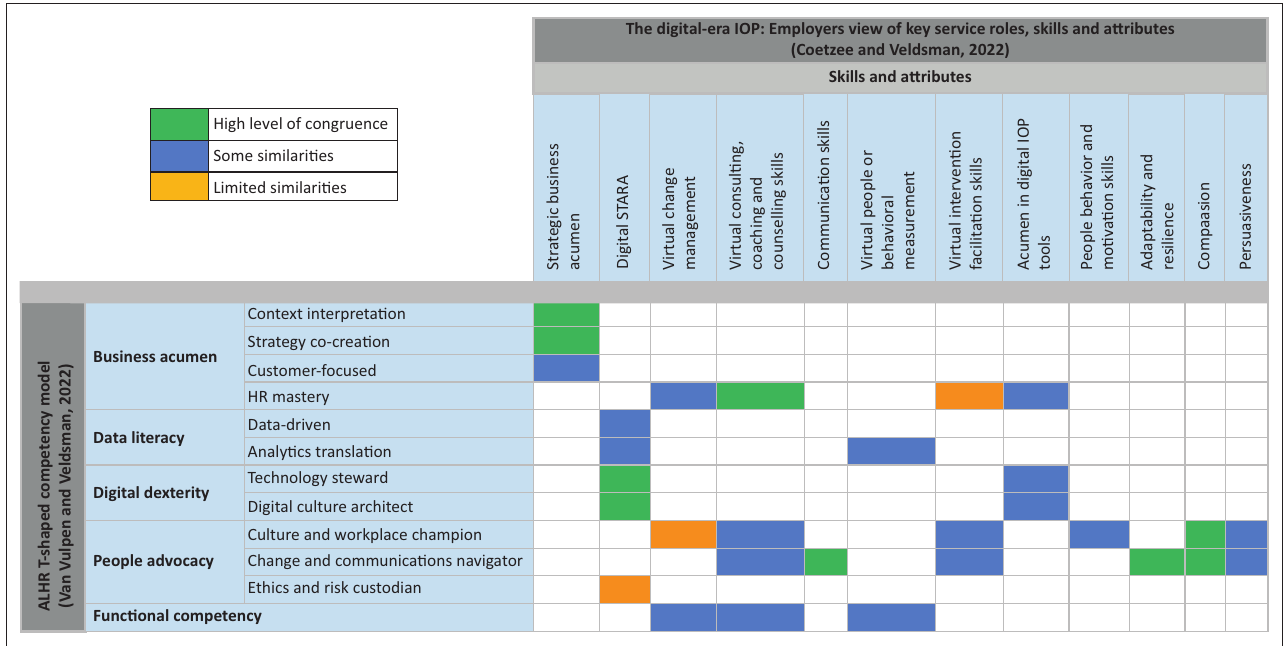
FIGURE 1: Convergences between the future-fit human resource professionals’ and industrial/organisational psychologists’ capabilities.